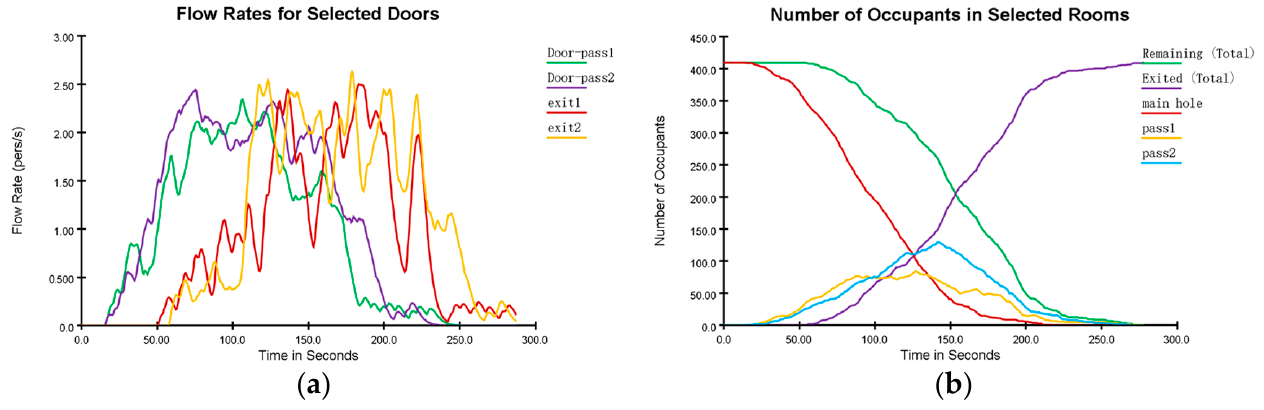
Figure 17. Results of evacuation simulation of working condition #1: ( a ) number of people passing through doors and exits; ( b ) relationship between the number of people and time in di ff erent areas.